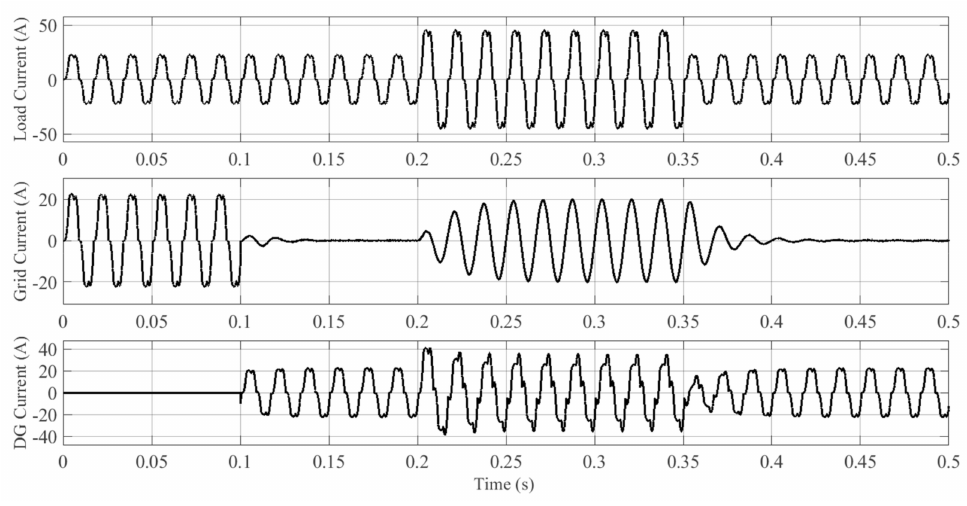
Figure 14. DTL VSI simulation results.